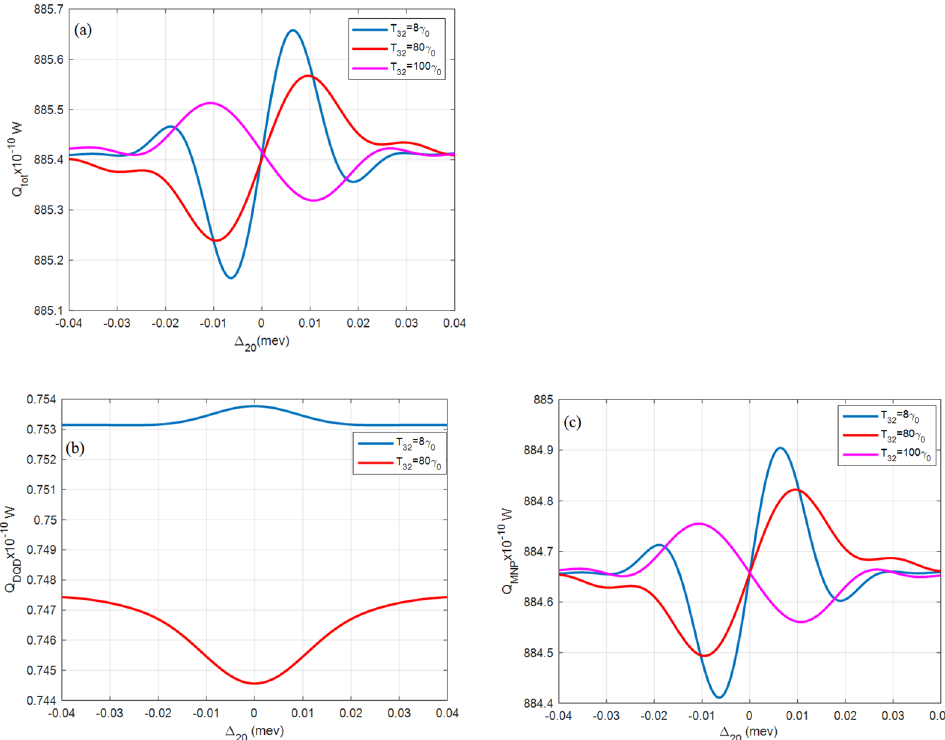
Figure 6. ( a ) The total ( Q tot ) , ( b ) DQD ( Q DQD ), and ( c ) MNP ( Q MNP ) absorption rates from the DQD-MNP hybrid system at R = 20nm and a = 10nm at different values of the tunneling component T 23 as in the inset and (cid:31) 0 02 = 0.09meV , � 0 13 = 1.8GeV, T 01 = 30 γ 0 .